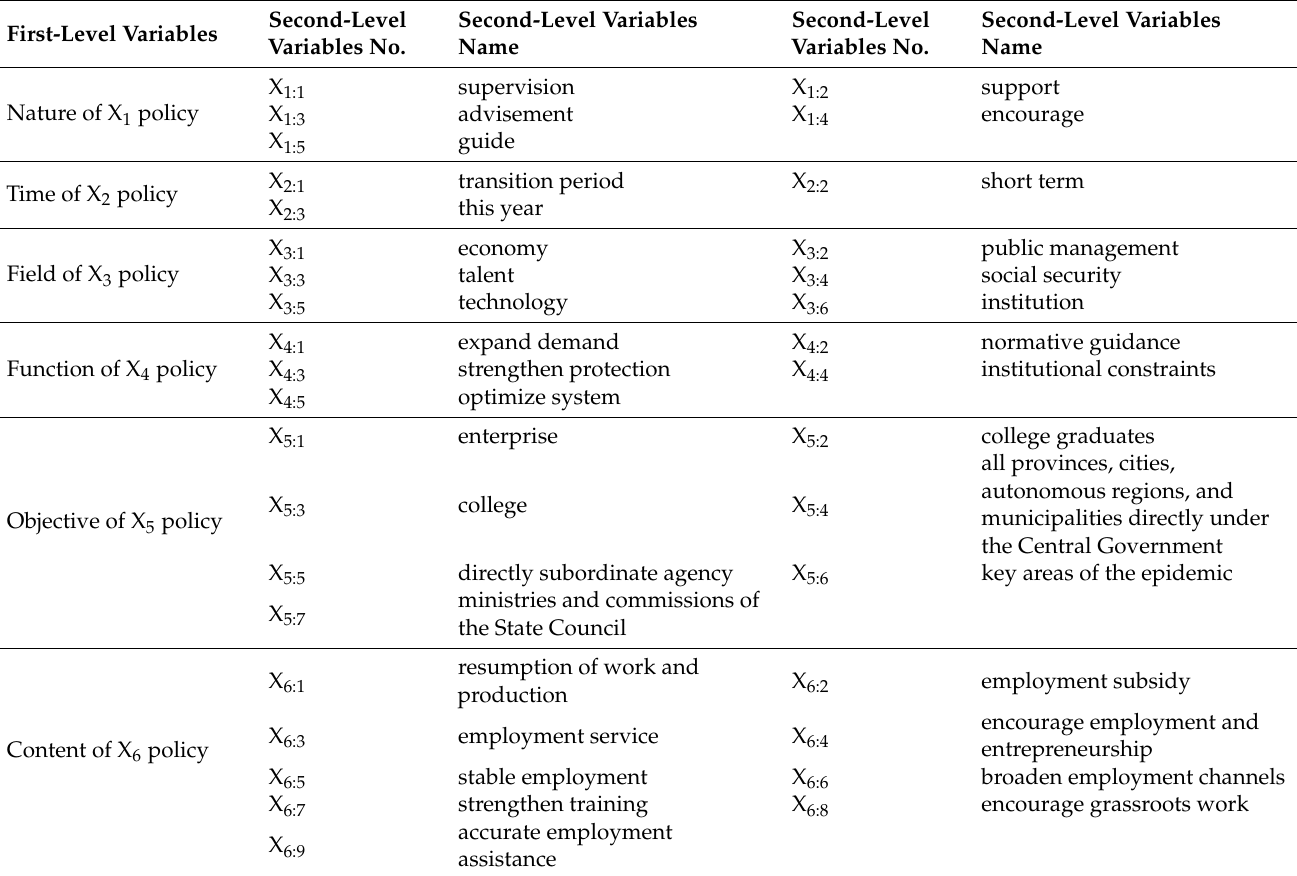
Table 3. PMC evaluation variables of employment promotion policy for